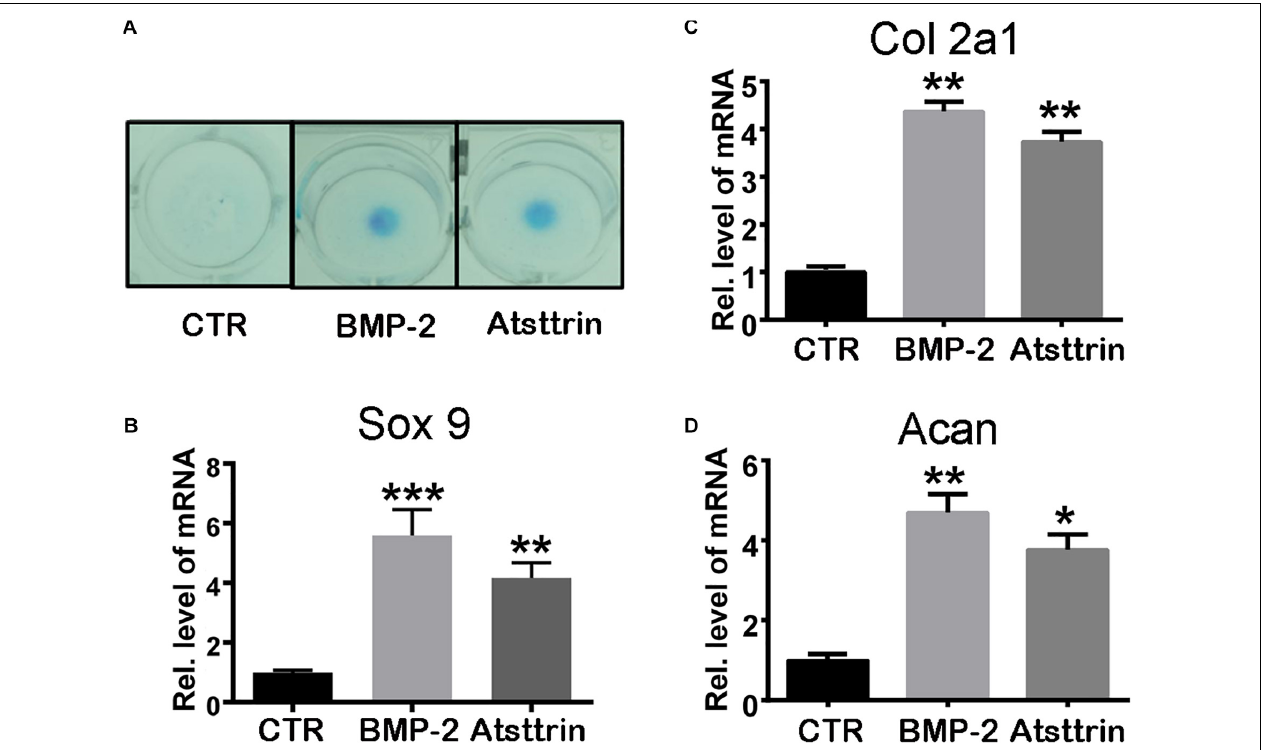
FIGURE 2 | Atsttrin promoted chondrogenesis in mouse primary bone marrow stem cells (BMSCs). (A) BMSCs were incubated in the absence (CTR) or presence of 100 ng/mL BMP2 or 1000 ng/mL Atsttrin for 10 days, followed by Alcian blue staining. (B–D) BMSCs were stimulated with either 100 ng/mL BMP2 or 1000 ng/mL Atsttrin, and real-time PCR was performed to examine the expressions of Sox9, collagen II (Col2a1), and aggrecan (Acan). Values were normalized to controls and set as 1. Experiments were conducted in triplicate. Three independent experiments were performed. *** P < 0.001, ** P < 0.01, * P < 0.05.